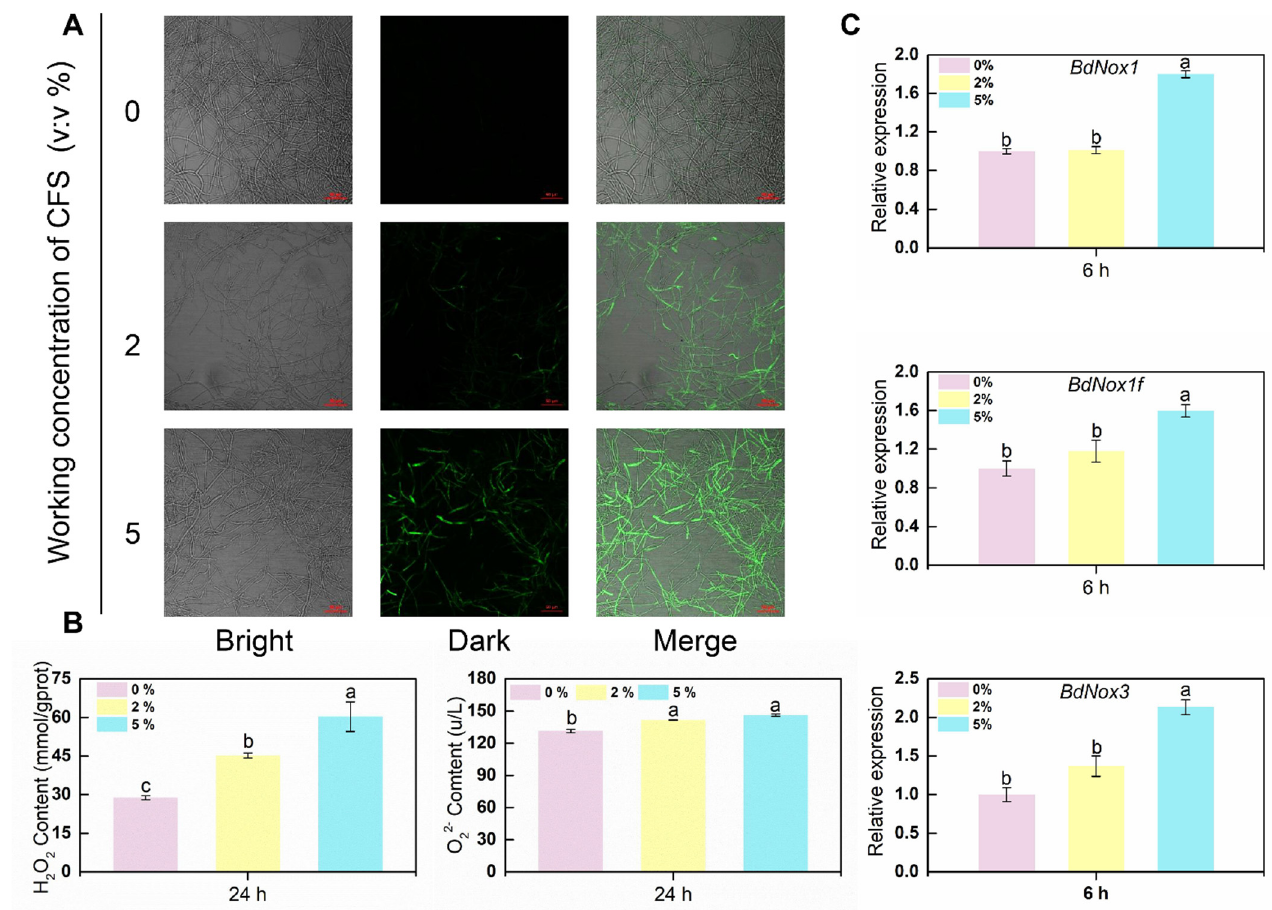
Figure 4. Effects of CFS on reactive oxygen species (ROS) accumulation in B. dothidea . ( A ) The images were recorded using confocal laser microscopy at 488 nm excitation and 520 nm emission. The hyphal cells treated with different concentrations of CFS were harvested after 24 h. Harvested hyphal cells were stained with the oxidant-sensitive probe, H2DCFDA, and then washed with PBS buffer for observation. ( B ) The contents of H2O2 and O 2 · − measured after 24 h treatment. ( C ) Gene expression levels of BdNox1, BdNox1f, and BdNox3 at 6 h after treatment. Different letters above the columns indicate significant differences within each group according to Duncan’s multiple range test ( p < 0.05).